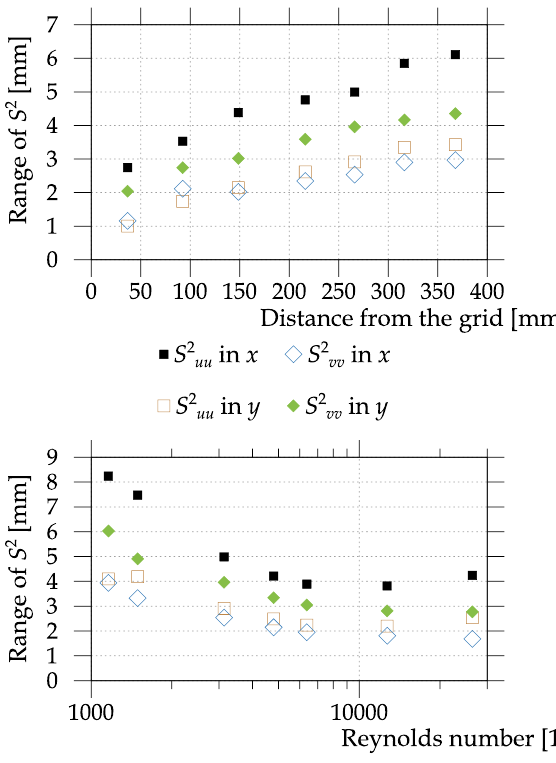
Fig. 10. Top : Range of structure function S 2 . The velocity is constant corresponding to Re = 3 . 1 · 10 3 . Bottom : the distance from the grid is constant and equals to x 0 =